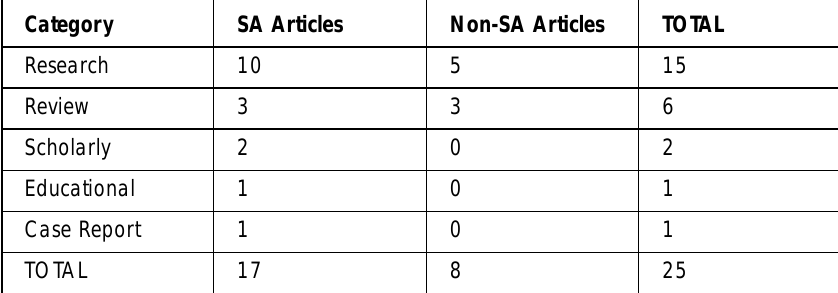
Table 3: Manuscript